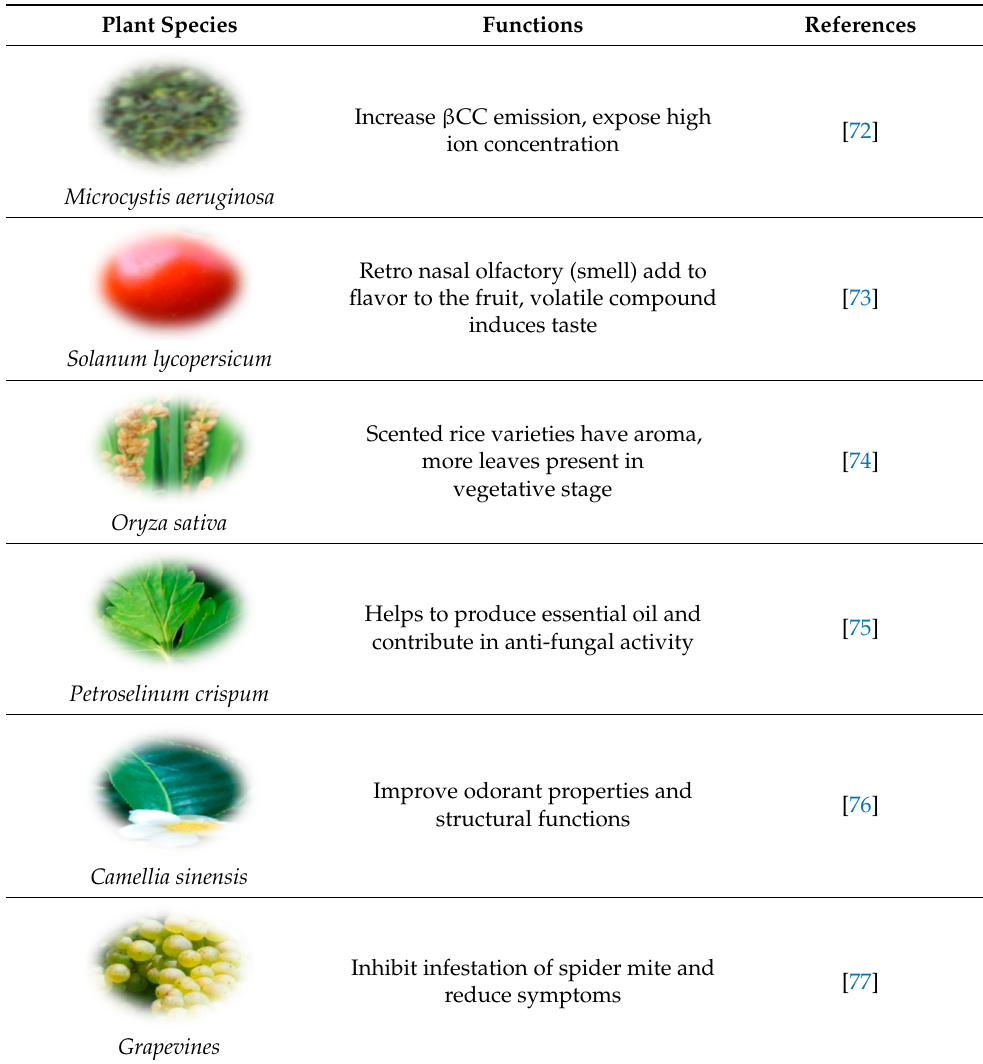
Table 1. Cont. Plant